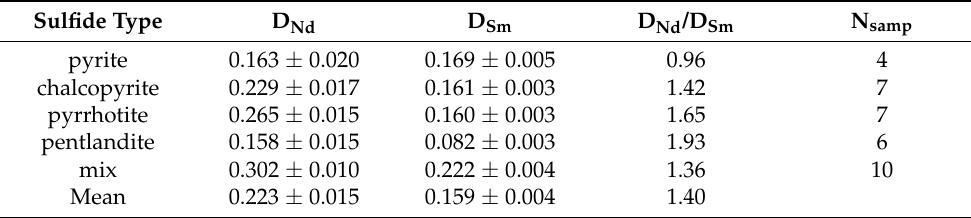
Table 2. Sulfide/rock partition coefficients of neodymium (D Nd ) and samarium (D Sm ) in